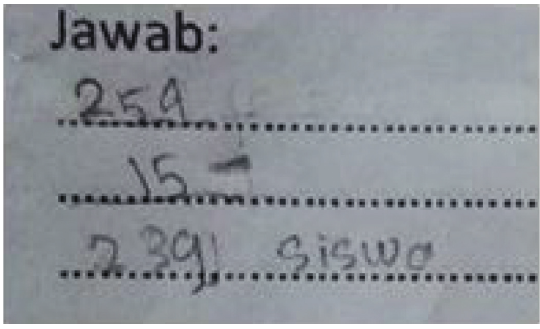
Figure 8: Student’s answer directed by the